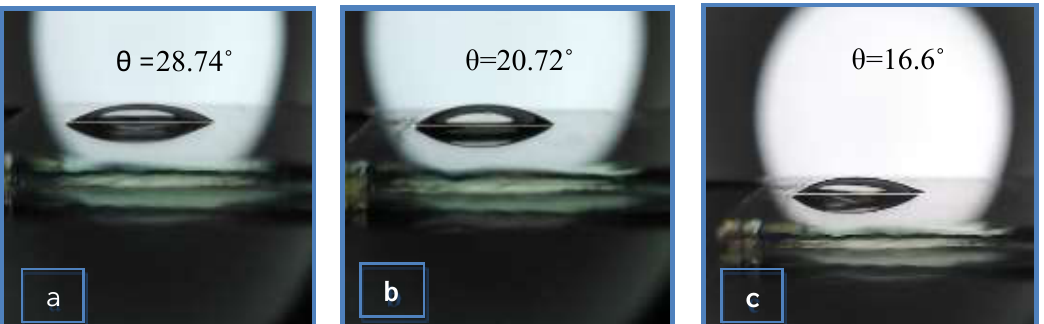
Fig8b: Images of water droplet on the sample pure TiO after15 min. of Vis irradiation c- an hour Vis irradiation.